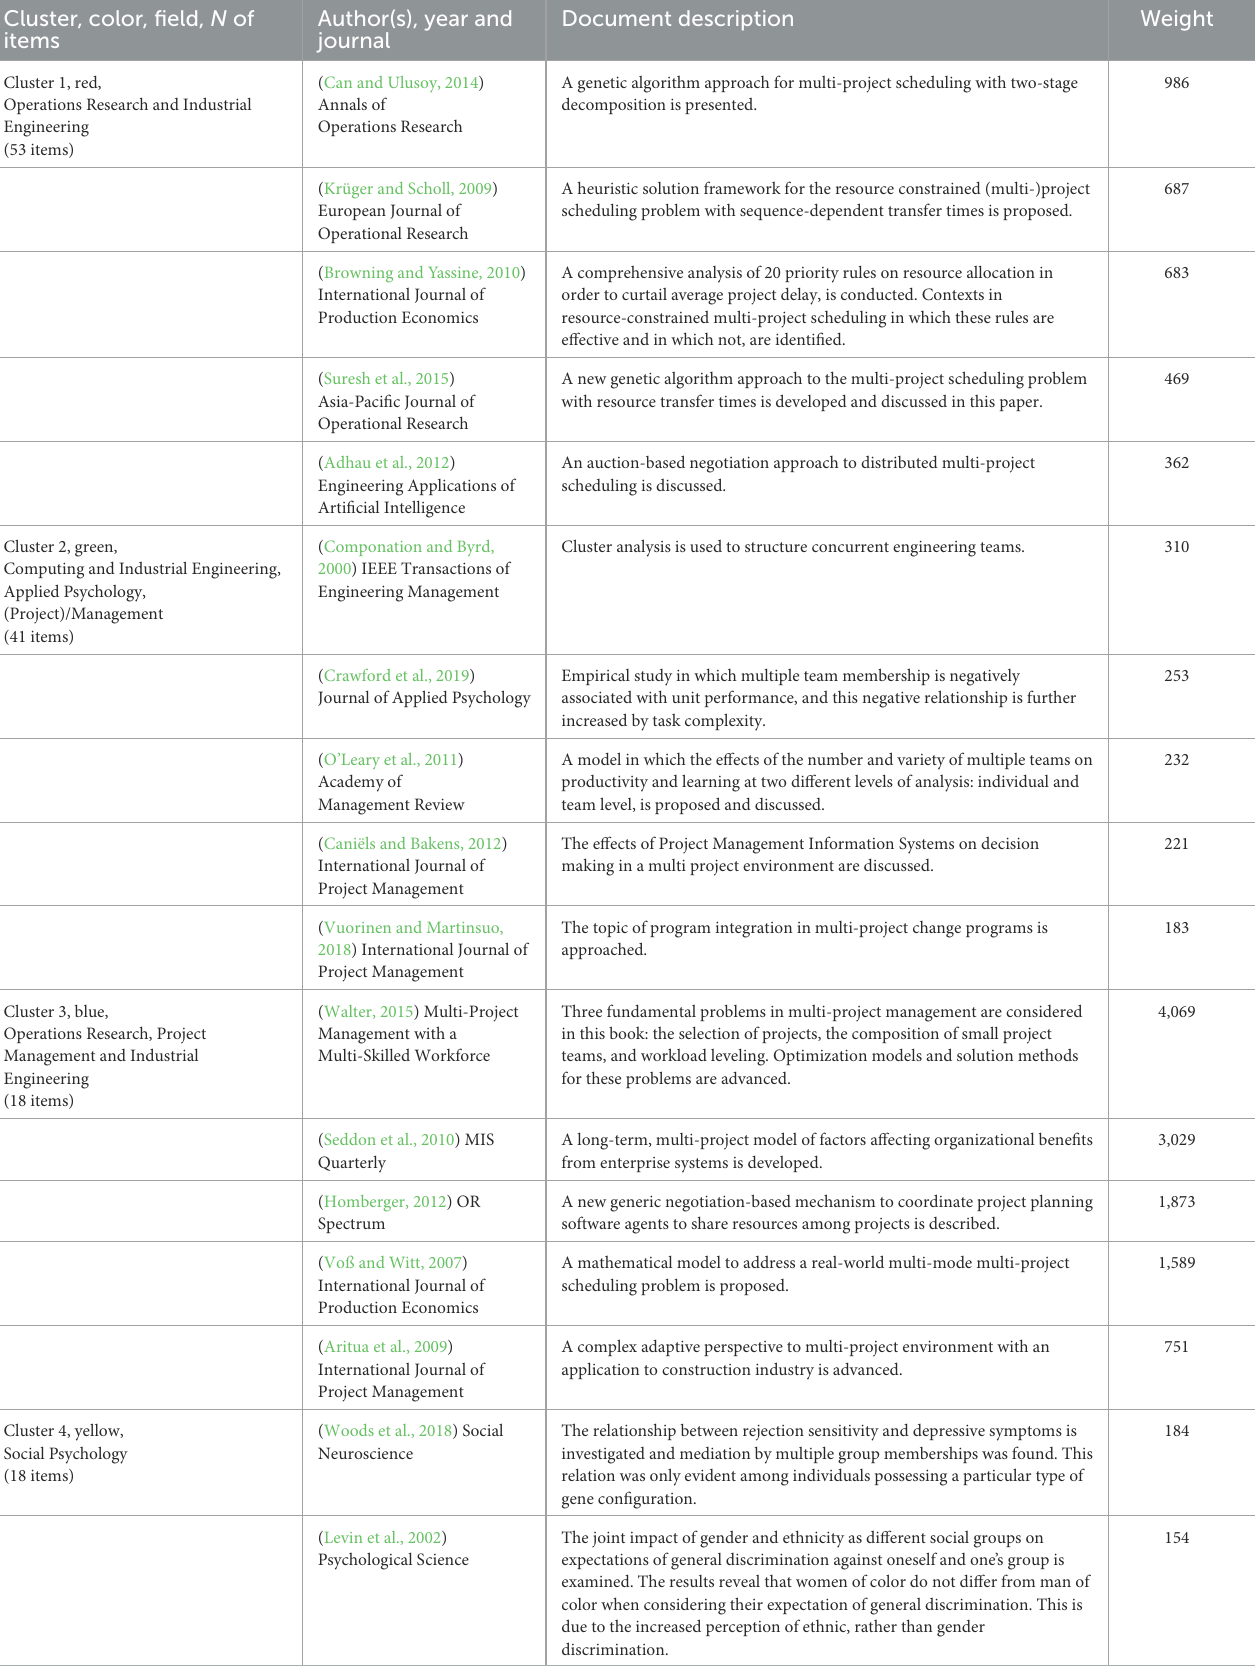
TABLE 2 Top 5 most important documents for each cluster in the bibliographic coupling analysis. Cluster, color, field, N of